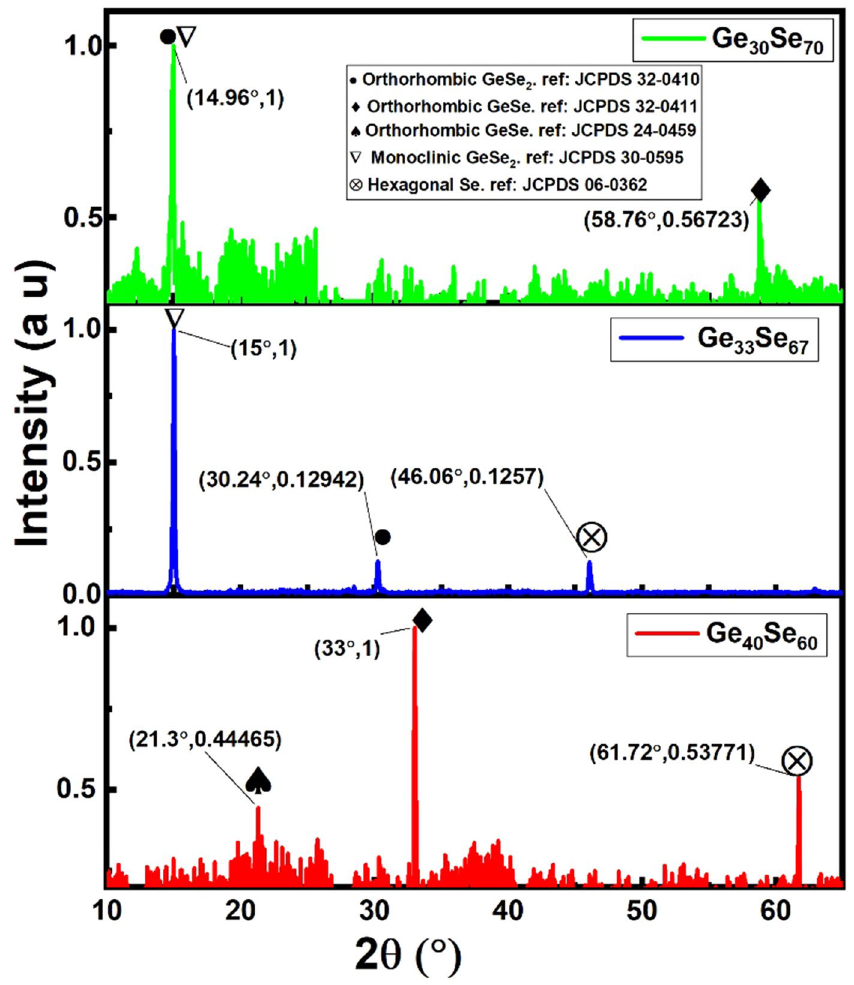
Figure 6. XRD of crystalline phases appearing after annealing of the films to the glass crystallization